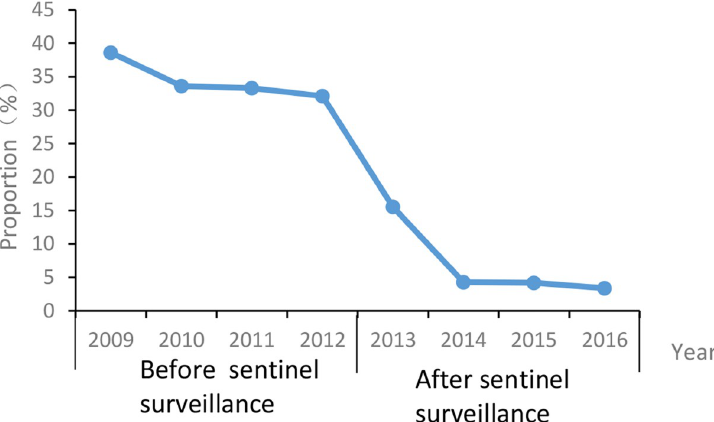
Fig 4. The proportion of unclassified hepatitis B, China, before and after sentinel surveillance. Fig 4 represents the proportion of unclassified hepatitis B, China, before and after sentinel surveillance. The proportion of unclassified hepatitis B is equal to the number of unclassified hepatitis B divided by the total number of hepatitis B cases.